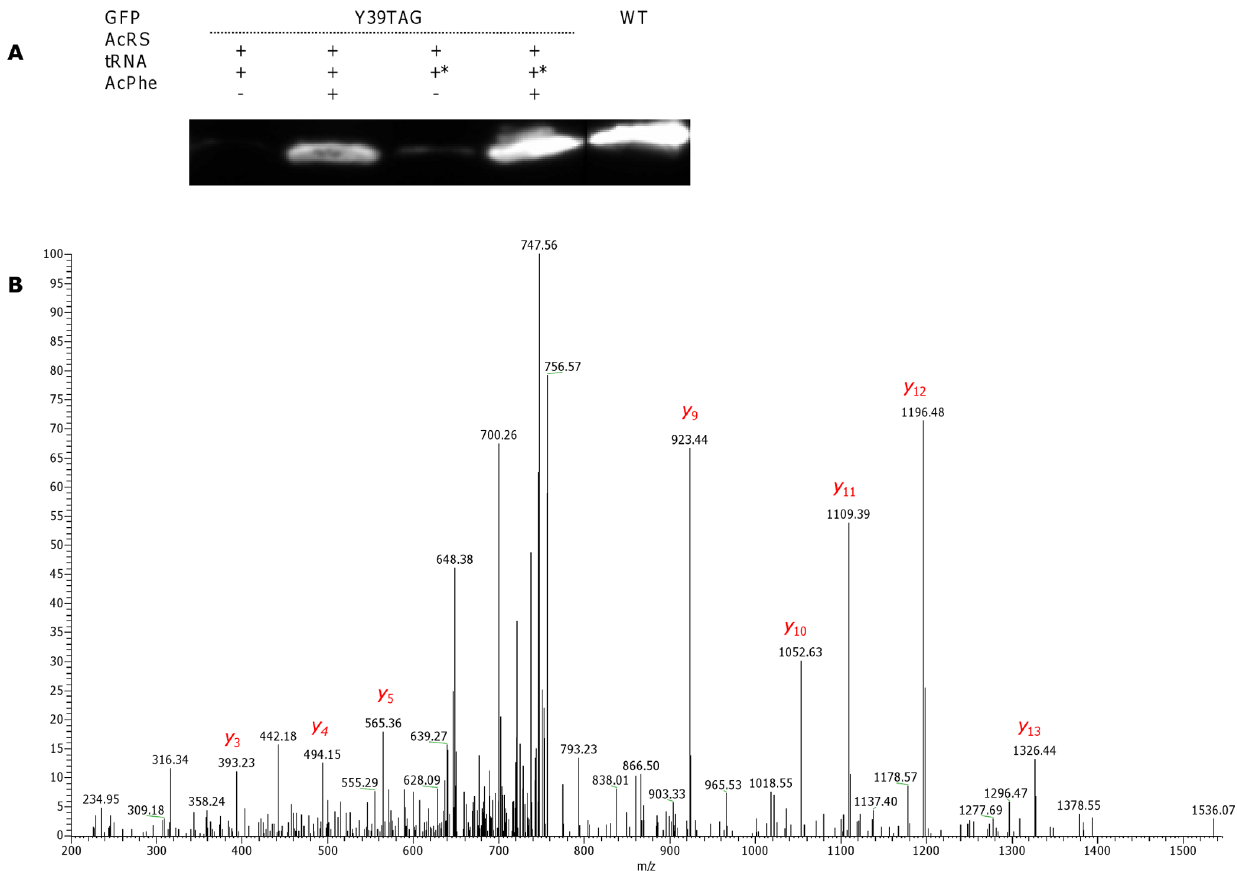
Figure 5. Site-specific incorporation of pIPhe into GFP in a cell-free expression system. (A) Western blot visualization of WT GFP and pIPhe-incorporated GFP Y39TAG. Co-translational incorporation of pIPhe was achieved by addition of M. jannaschii IPheRS (100 m g/mL), different types of suppressor tRNA (480 m g/mL), and pIPhe (1 mM) to the reaction medium. tRNA denotes synthetic Mj tRNA CUA , Opt – tRNA CUAOpt . (B) Annotated MS/MS spectrum of the FSVSGEGEGDATY*GK peptide from GFP Y39IPhe. The mass shift between pIPhe and tyrosine was calculated to be 109.9 Da, corresponding to the observed ‘‘y’’ ions.